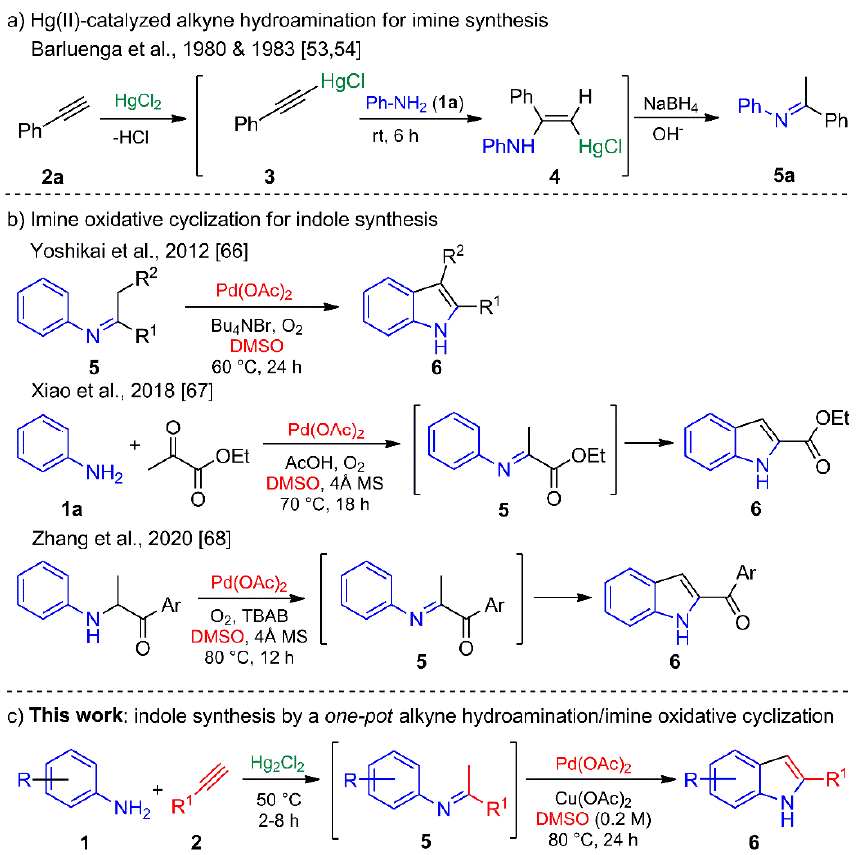
from imines derived by a condensation reaction and Pd(II)-catalyzed oxidative cyclization. ( c ) Pd(II)- catalyzed indole synthesis from imines derived from Hg(I)-catalyzed alkyne hydroamination.